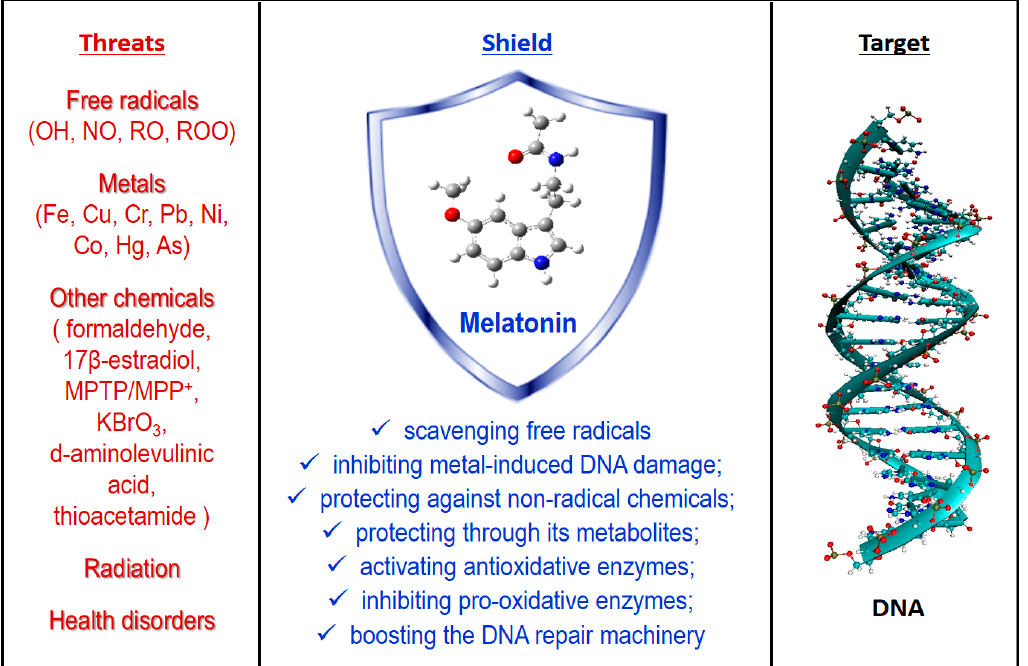
Figure 2. Some threats to DNA integrity and some pathways involved in melatonin’s protection. See text for details and references.